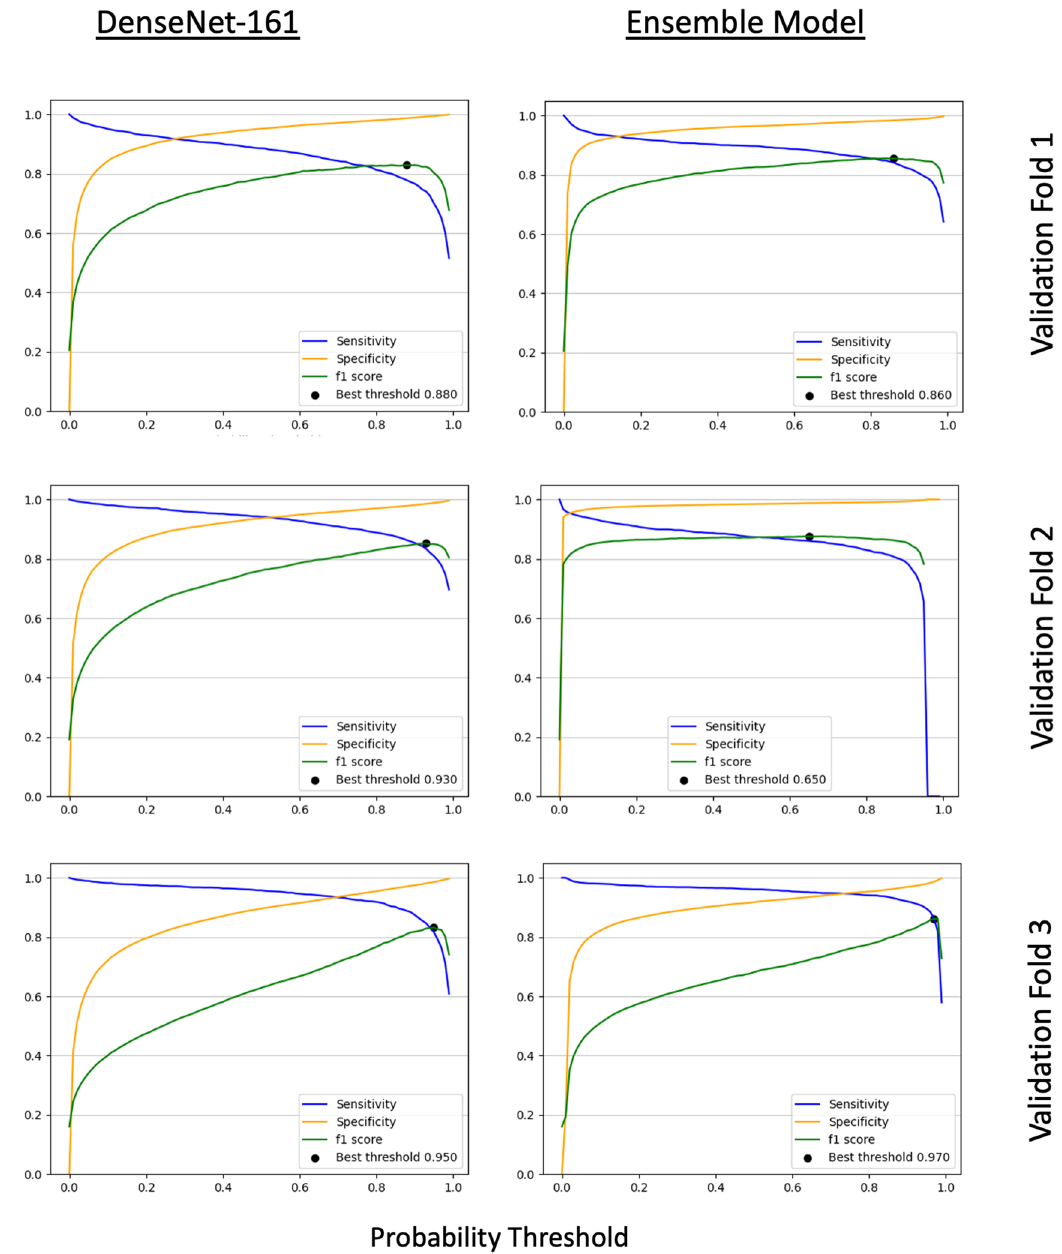
Figure 4. Line graphs that depict the sensitivity, specificity and weighted F1-score calculated for each probability threshold, for the three validation folds from the DenseNet-161 and ensemble models. To determine the optimal probability threshold, we choose the threshold with the highest F1-score. In the above plots, these are denoted as ”Best threshold”. For example, for the ensemble model, in validation fold 1, this threshold was 0.86, for fold 2 it was 0.65 and for fold 3 it was